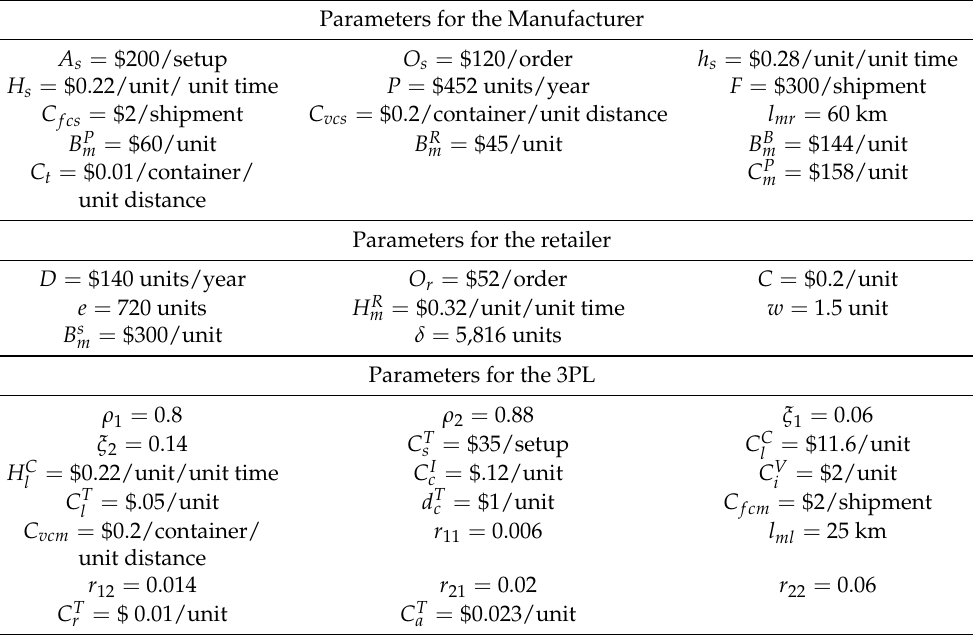
Table 3. Input data set.